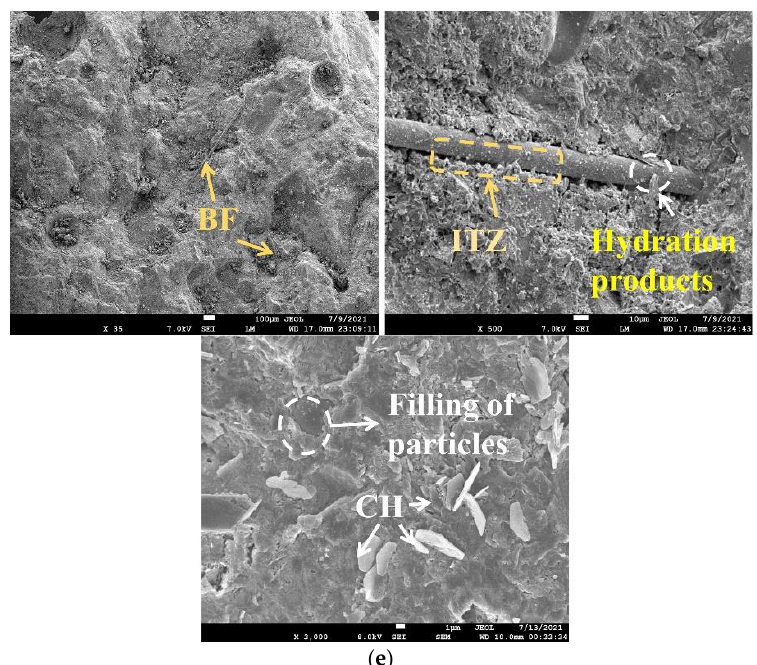
Figure 11. Micromorphology of BFR-GTCM for 28 days: ( a ) BFGT000; ( b ) BFGT020; ( c ) BFGT120; ( d ) BFGT220; ( e ) BFGT320.